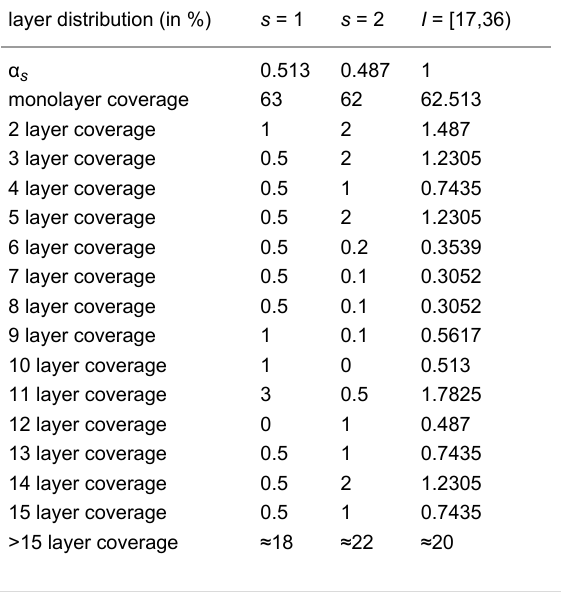
Table 3: Coverage of j -layer GMSE3 graphene regions by the model in Equation 3. layer distribution (in %)